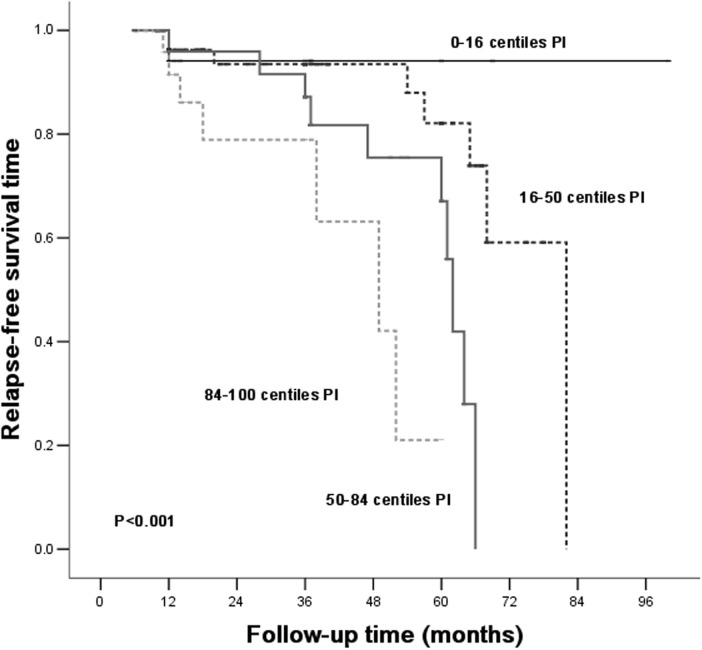
Kaplan-Meier cumulative IgAN relapse-free rate according to the PI based on Table 4, relapse-free survival analysis of the Primary Cohort.